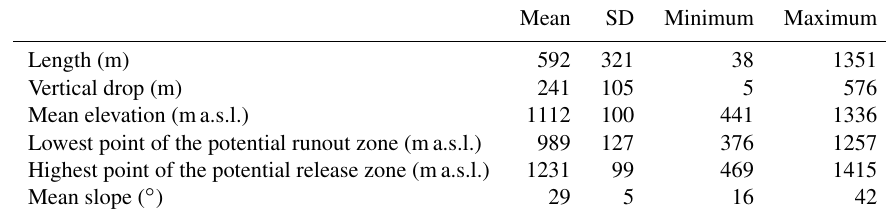
Table 4. Topographic characteristics of the avalanche paths where the 520 events that could be precisely located occurred. These were obtained by crossing the path GIS shape files with a 5m resolution digital elevation model. The statistics take into account the specific activity of each path (when several avalanches, say N , occurred in the same path, the path’s characteristics are weighted by a factor N